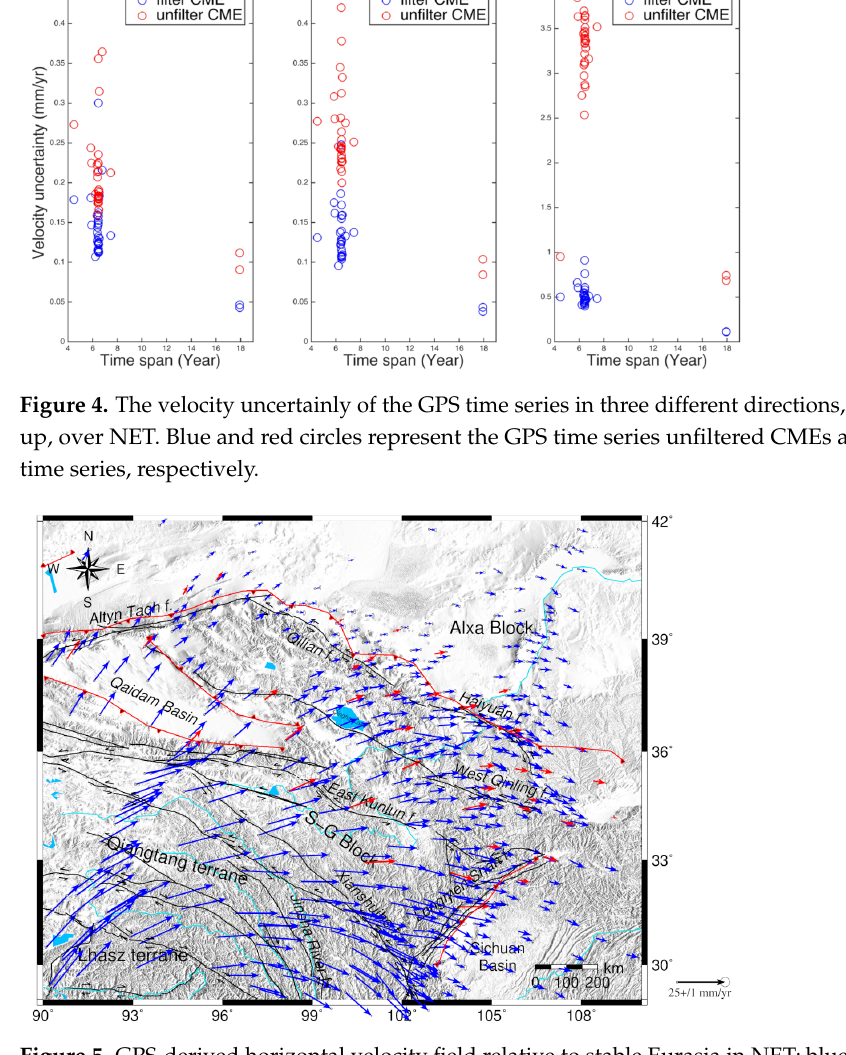
Figure 5. GPS-derived horizontal velocity field relative to stable Eurasia in NET; blue arrows and red arrows represent the velocities for campaign-mode stations and CGPS, respectively; the light gray ellipse at each velocity vector is 95%